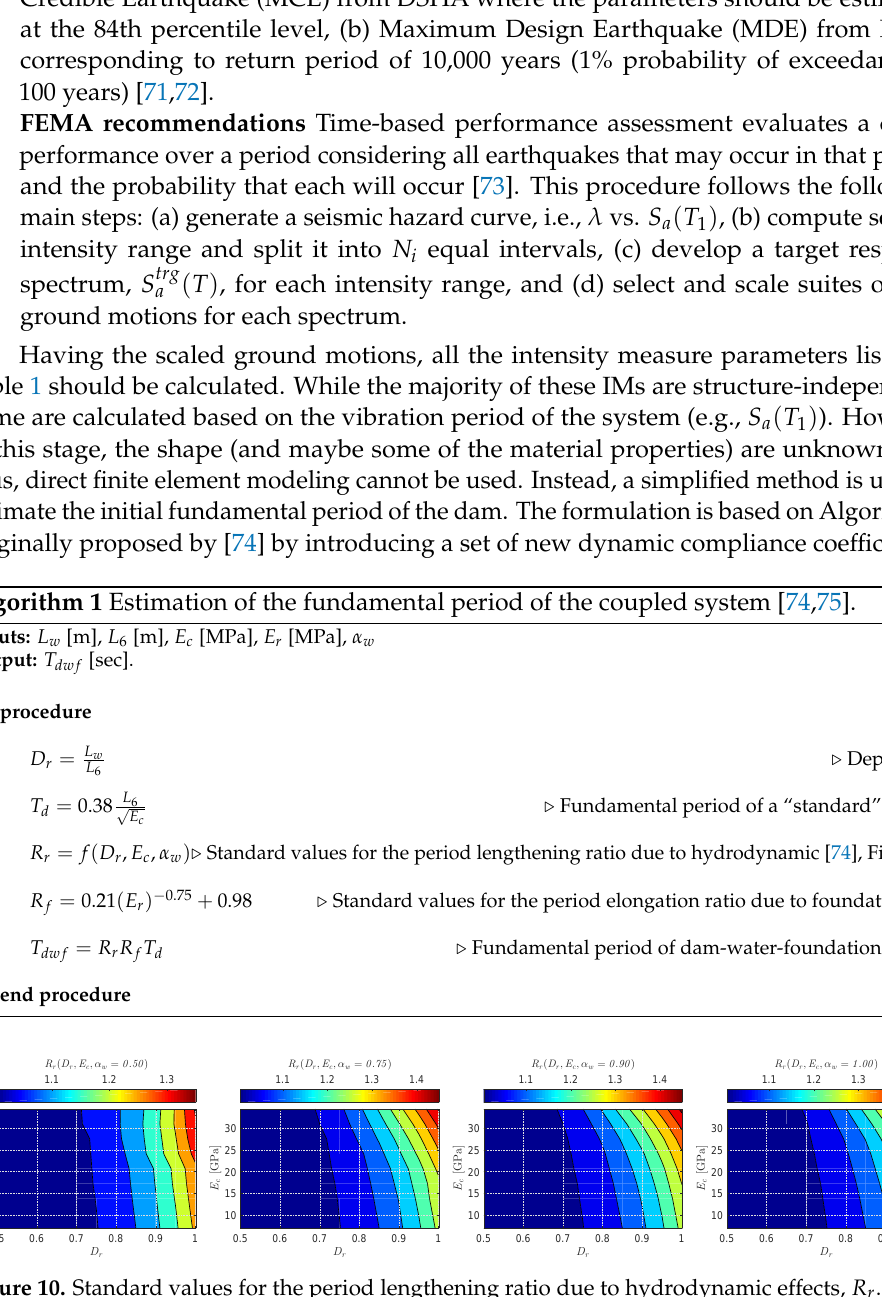
Figure 10. Standard values for the period lengthening ratio due to hydrodynamic effects, R r